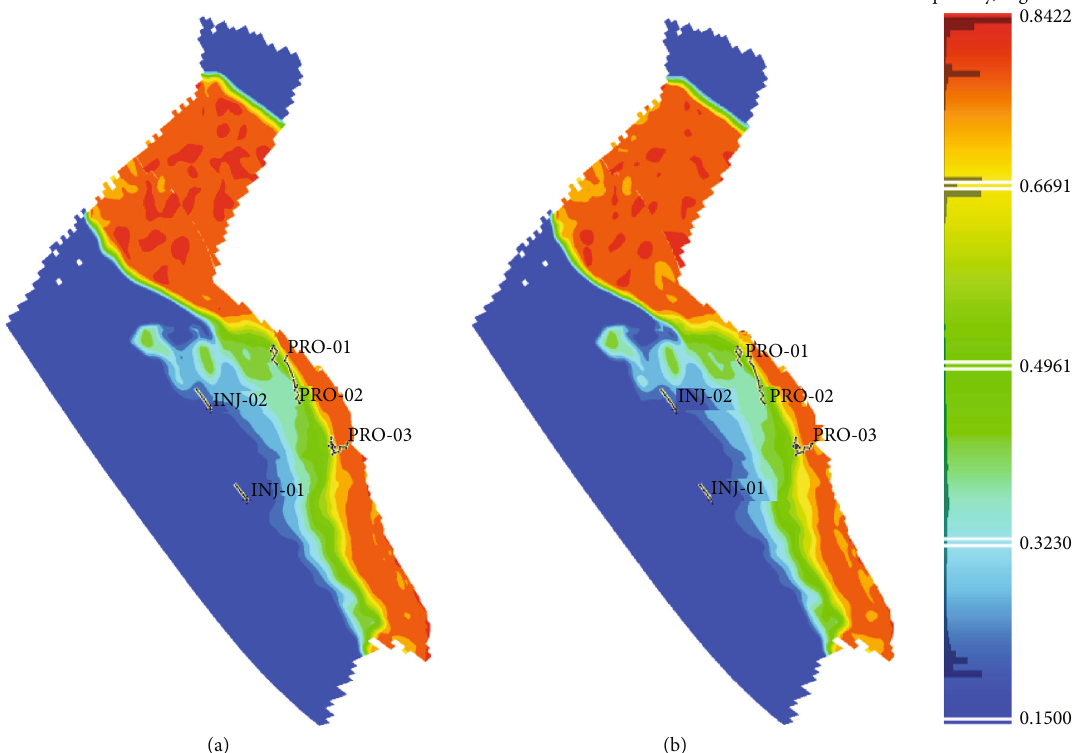
Figure 14: Comparison chart of the remaining oil saturation